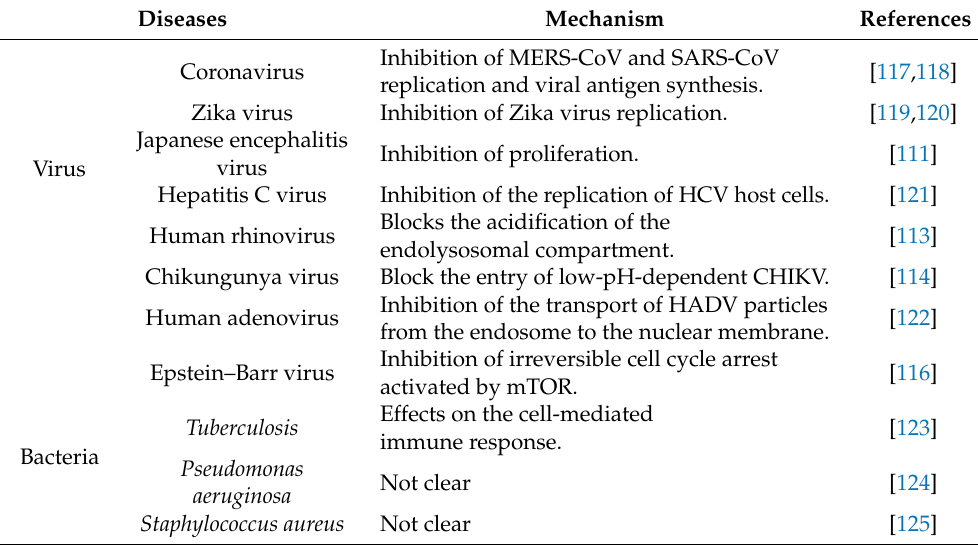
Table 3. The pharmacological activities and mechanisms of NIC and its derivates against virus and bacterial